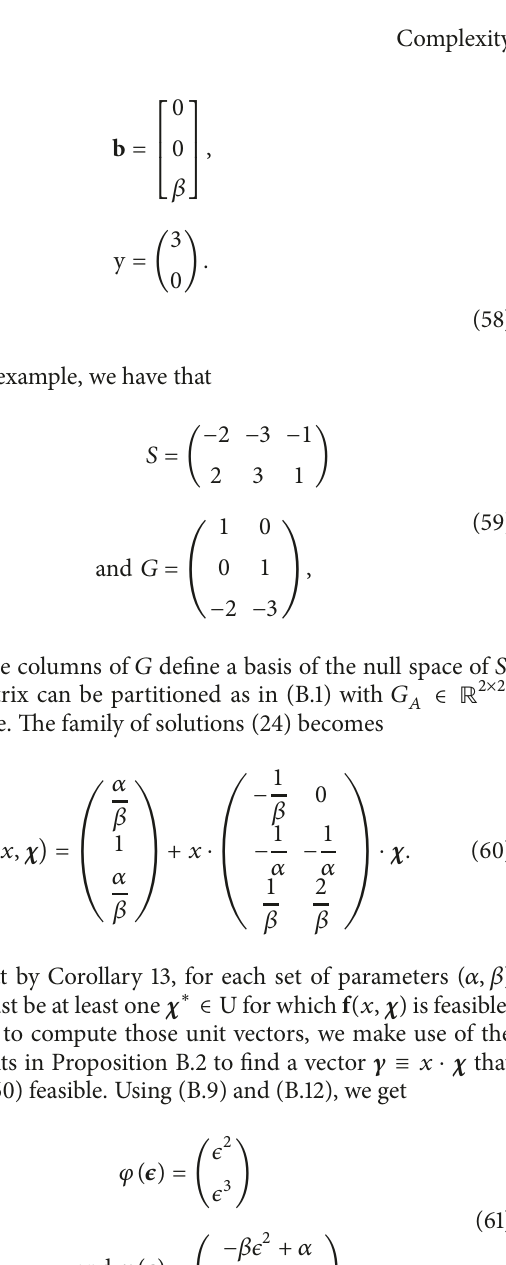
mass conservation constant within a certain range (including 𝜎 = 500 ). Multistationarity arises via equilibrium folding, in agreement with the results presented in the previous section for deficiency-one